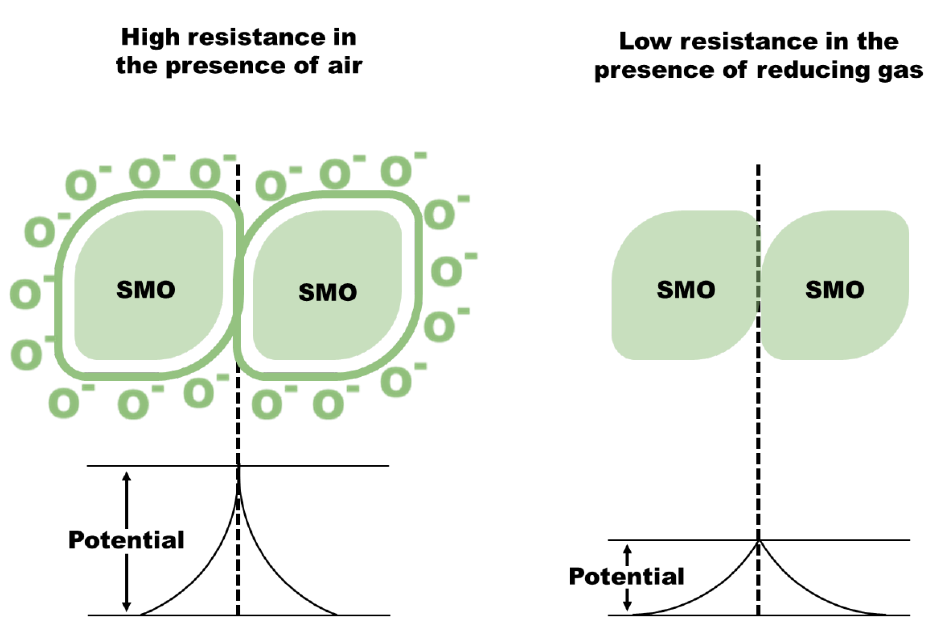
Figure 5. Change in charge carrier concentration in an SMO (n-type): Left—depletion layer formation (causes high potential barrier) on the surface in the presence of air. Right—reaction of target (reducing gas) with O 2 reduces potential barrier.